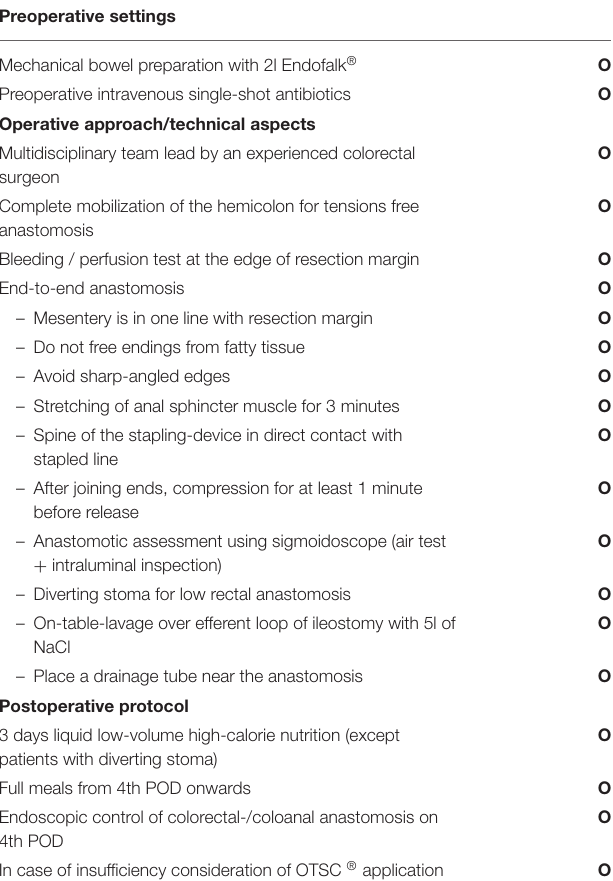
TABLE 1 | Fail-safe protocol for laparoscopic elective rectal resections in this study. Preoperative